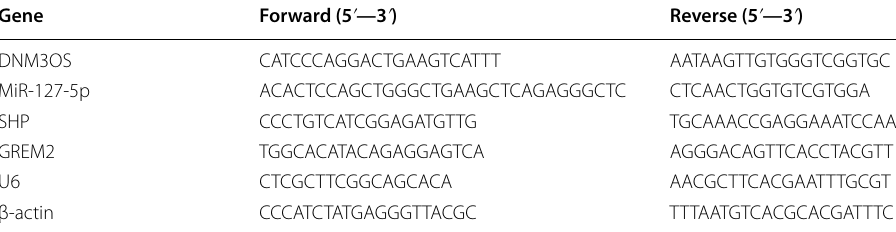
Table 1 Primer sequences used for RT-qPCR